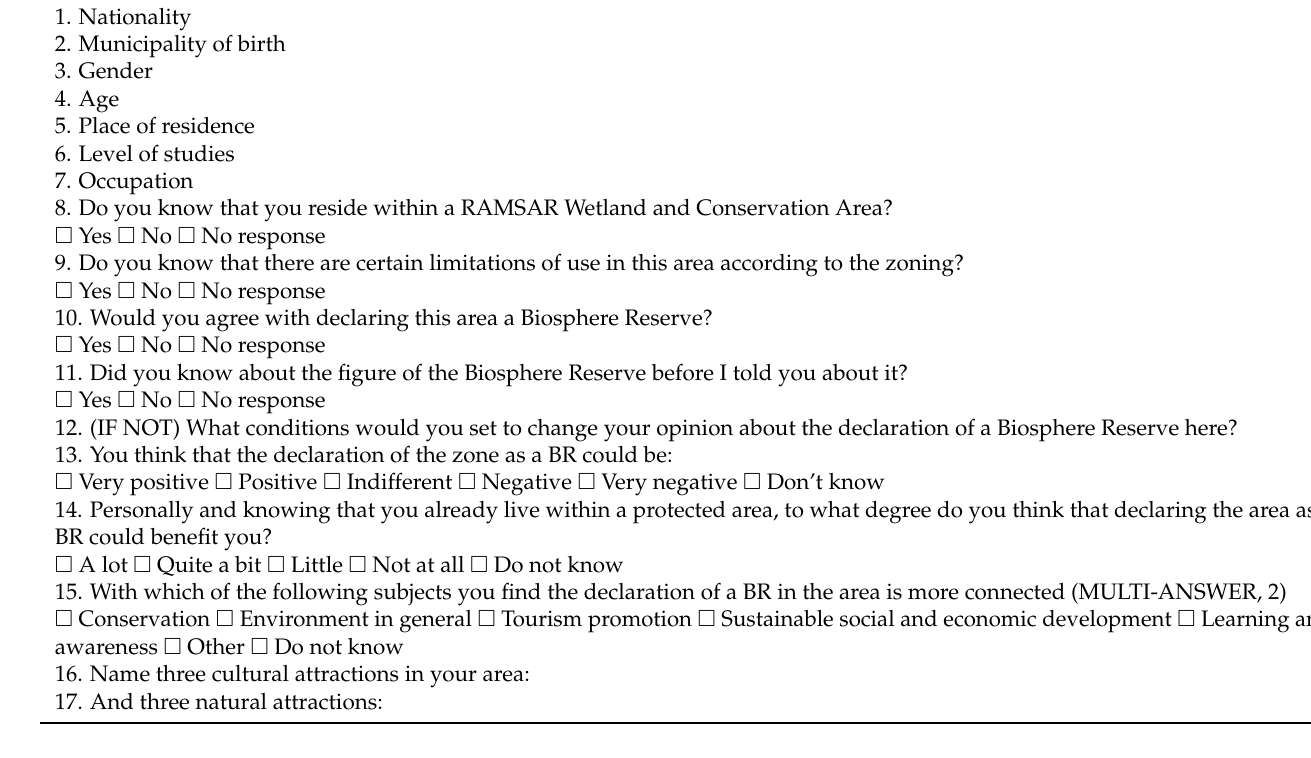
Table A1. Survey form used in the data